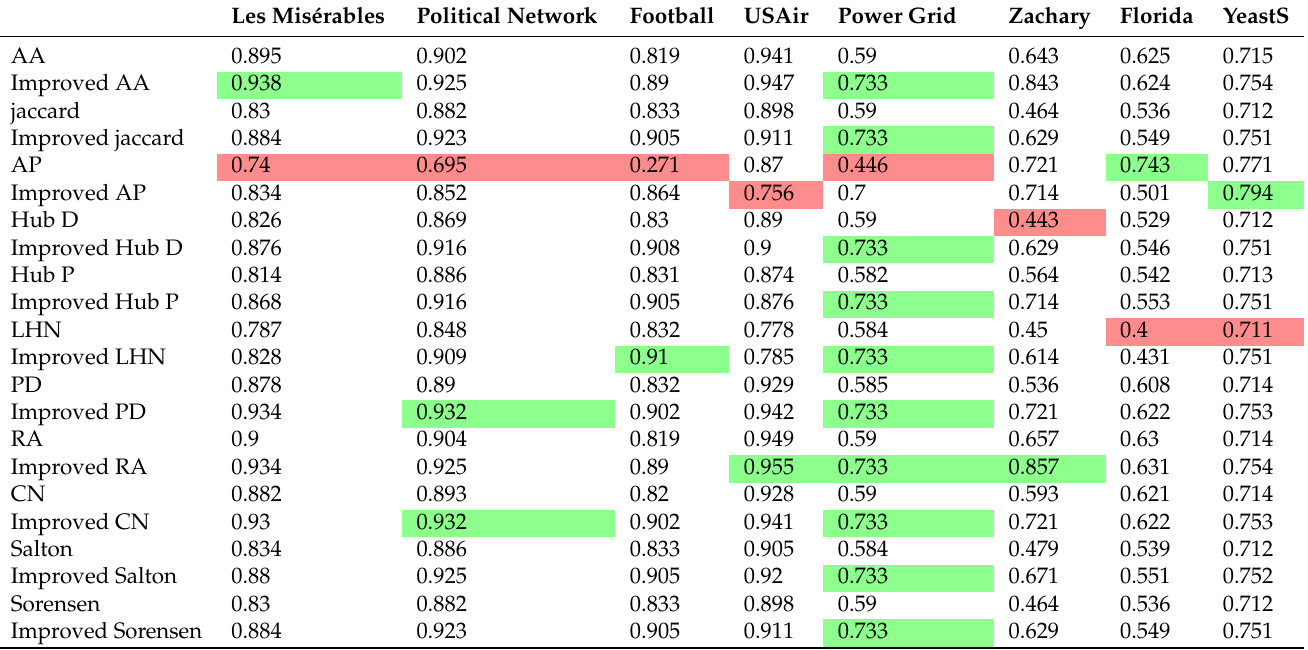
Table 4. AUC results of both simple metrics and improved metrics, cells in green represent the metrics having the highest AUC values for each dataset, and cells in red represent the metrics having the smallest AUC values for each